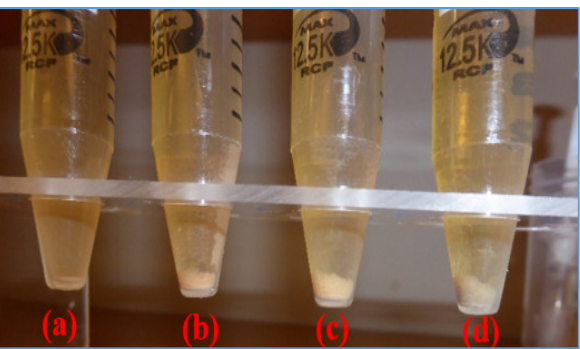
Figure 15. Solids precipitated in filtrates: ( a ) Ref ( b ) Ref + 0.09 wt.% ( c ) Ref + 0.19 wt.% ( d ) Ref + 0.26 wt.%.